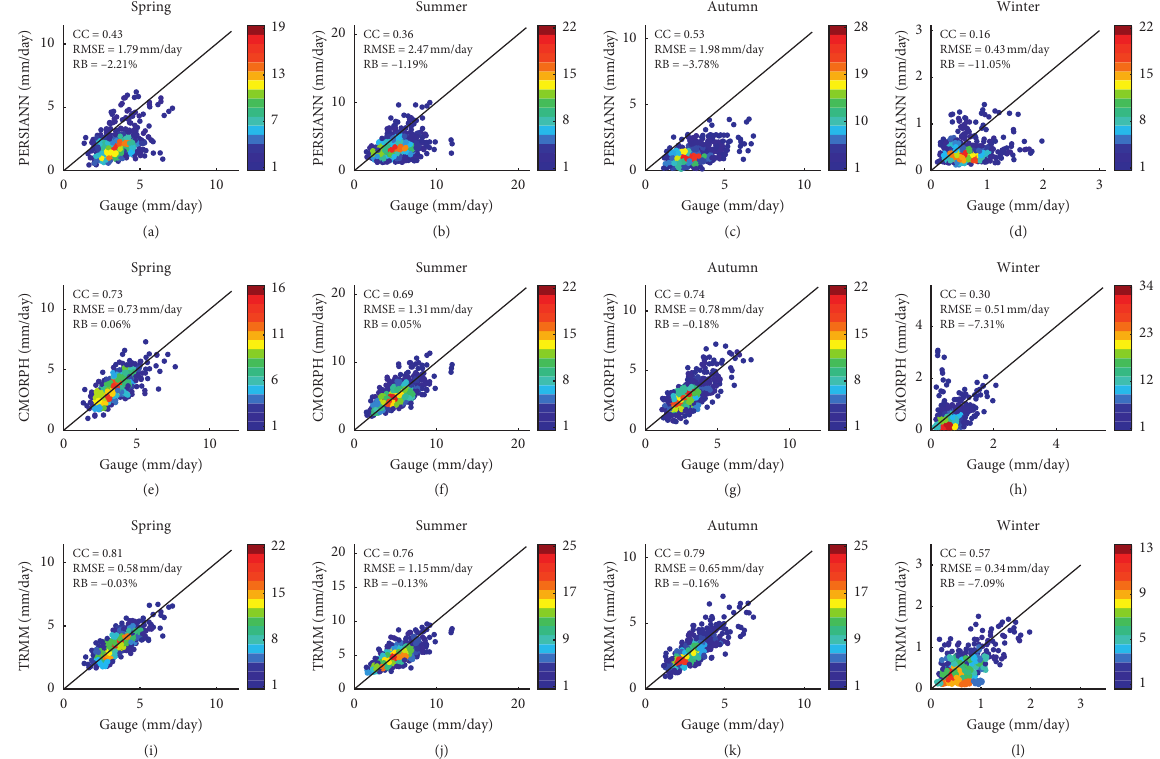
Figure 15: Scatter plot of average daily precipitation in spring (a, e, i), summer (b, f, j), autumn (c, g, k), and winter (d, h, l) in the Three Gorges Reservoir area.